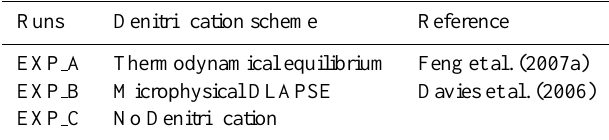
Table 1. SLIMCAT model